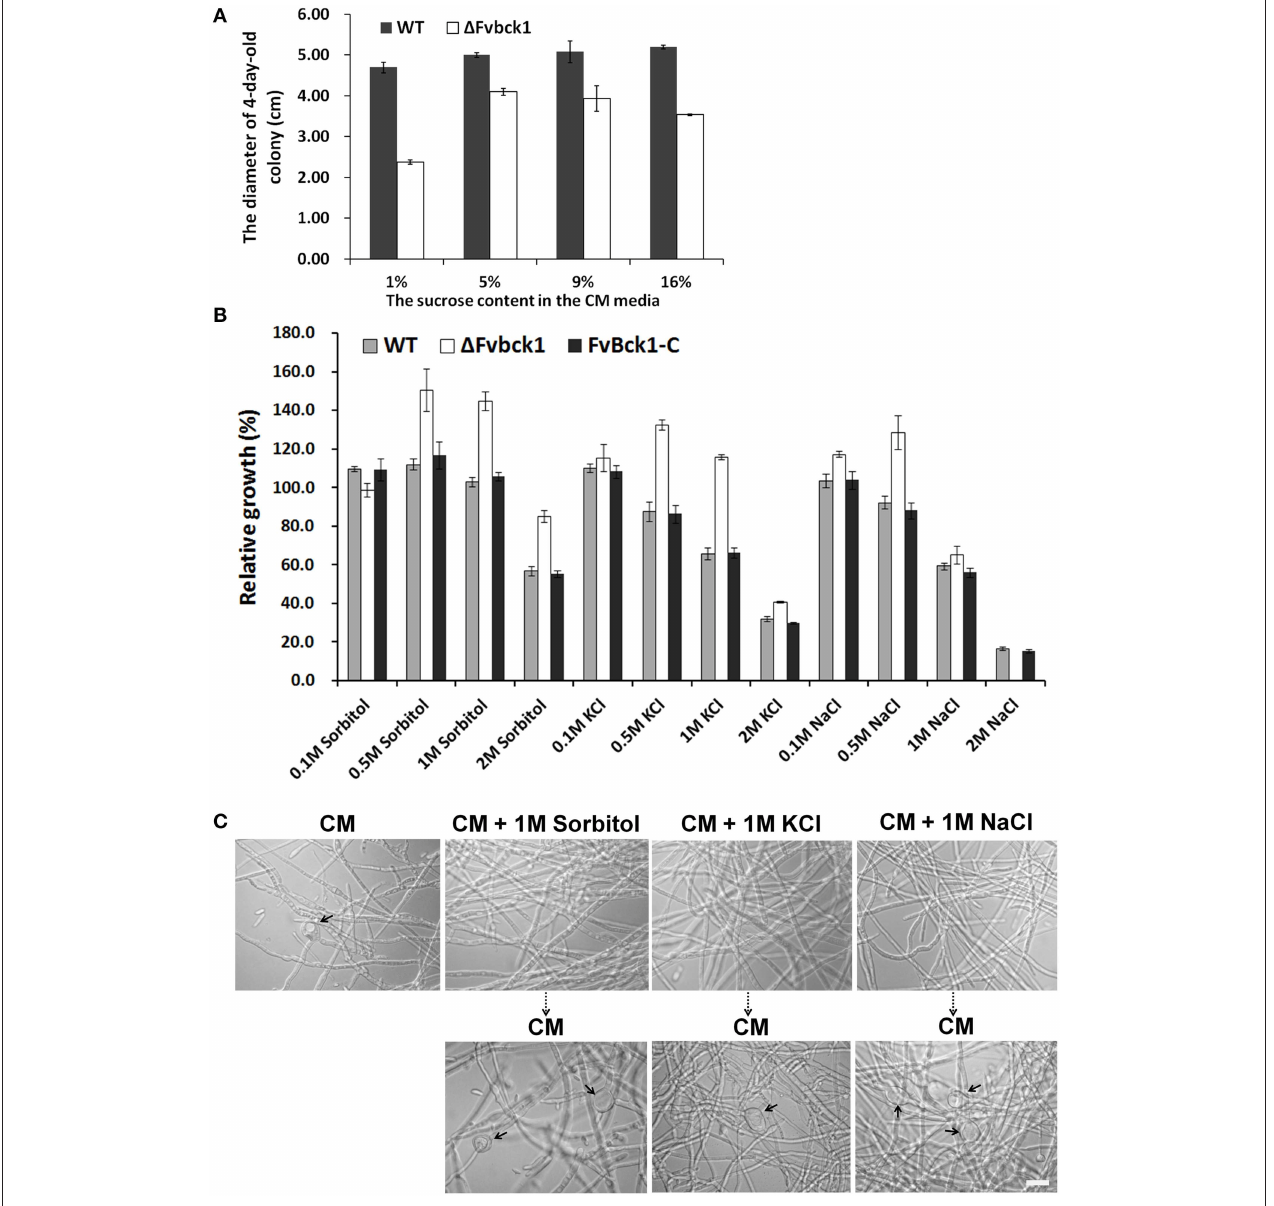
FIGURE 4 | The sensitivity of WT, 1 Fvbck1, and FvBck1-C strains to osmotic stress. (A) The colony diameter of WT and 1 Fvbck1 strains grown on CM plates with different concentration of sucrose for 4 days. (B) Relative growth of WT, 1 Fvbck1, and FvBck1-C strains grown on CM plates with different concentration of Sorbitol or KCl or NaCl for 4 days. Strains grown on CM plates considered as control (100%). (C) Hyphal morphology of 1 Fvbck1 strain grown in liquid CM medium with or without 1M Sorbitol or KCl or NaCl for 3 days (upper panels) and then shift to CM medium for an additional day (lower panels). The arrows indicate the swollen structures. Bar = 20 µ